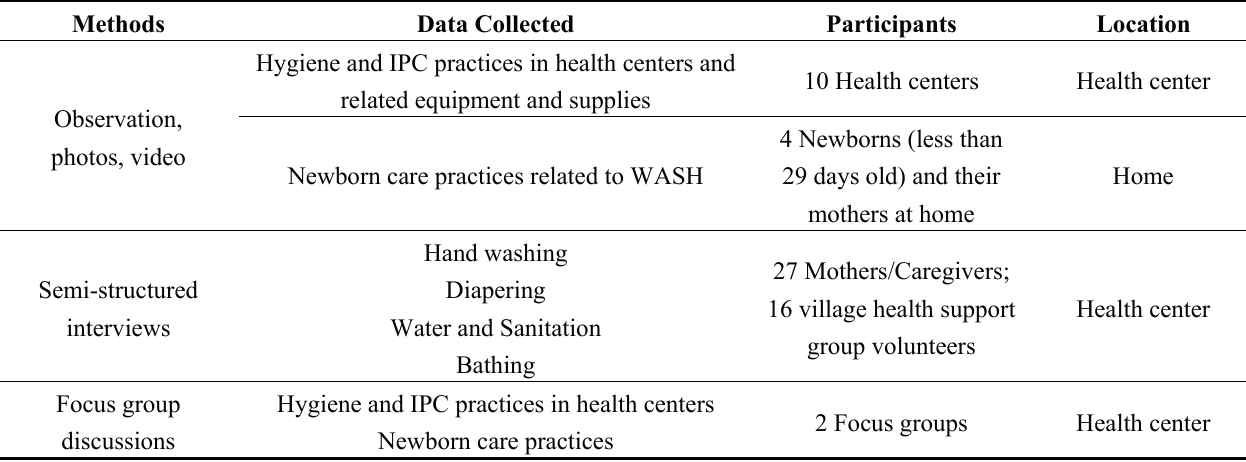
Table 1. Data collection methods and participants.